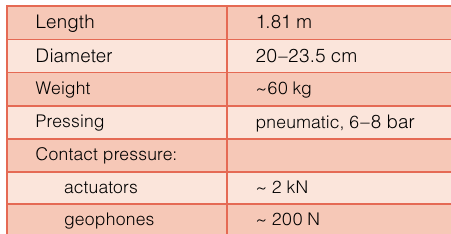
Table 1. Parameters of the